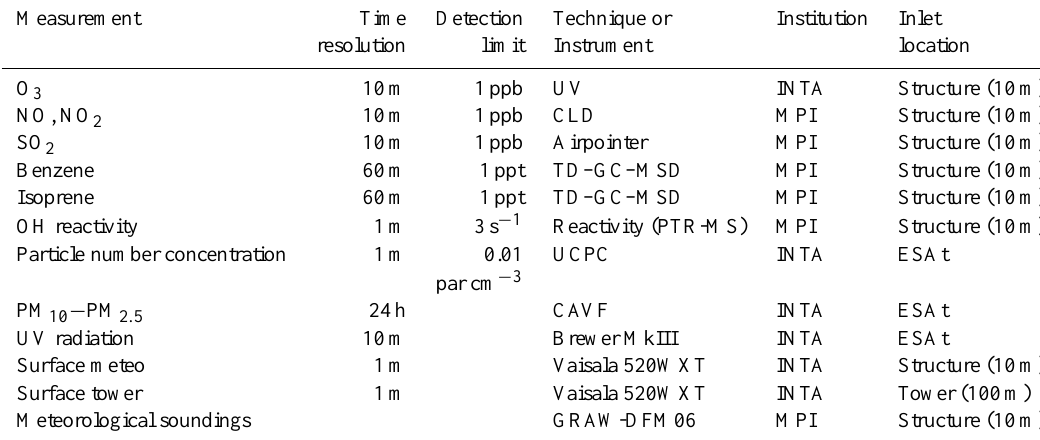
Table 1. The measurements made during the DOMINO campaign are tabulated alongside, parameter, time resolution, detection limit, re- sponsible institute and location of the